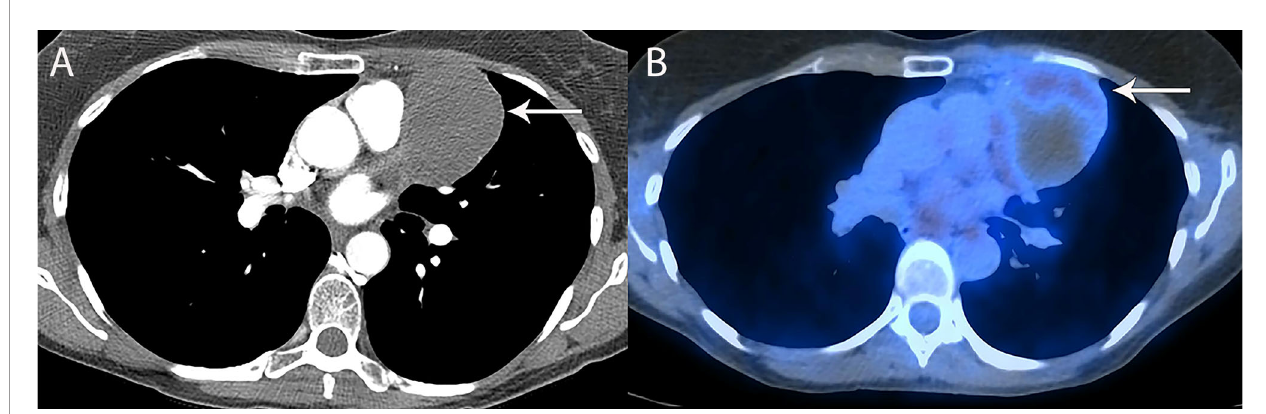
FIGURE 3 | 53 year old woman with thymoma. (A) CT shows the left prevascular mediastinal mass (arrow) is mostly homogenous, with low attenuation measuring 10 Houns fi eld Units suggesting a cystic component, yet has a denser component of 48 Houns fi eld Units along the anterior peripheral aspect suggesting some solid component. (B) PET/CT shows FDG uptake with SUVmax of 3.4 along the anterior peripheral aspect of the mass (arrow). At resection, pathology showed thymoma with cystic component and no invasion of the pericardium or